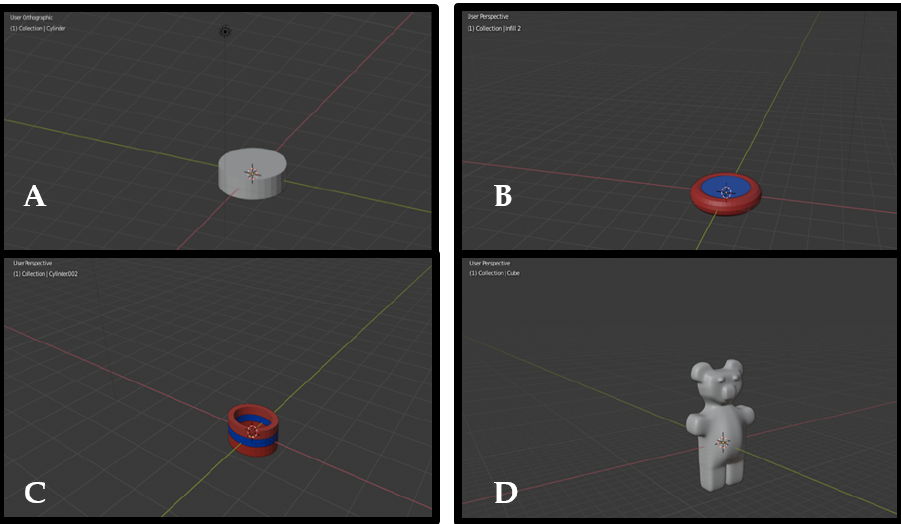
Figure 1. CAD of ( A ) design 1—disc shape (12 × 5 × 4 mm) ( B ) design 2—torus shape (12 × 6 × 3 mm) ( C ) design 3—ring shape (9 × 5 × 5 mm) ( D ) design 4—gummy ‐ bear shape (11 × 20 × 3 mm), all rendered in Blender v. 2.8.